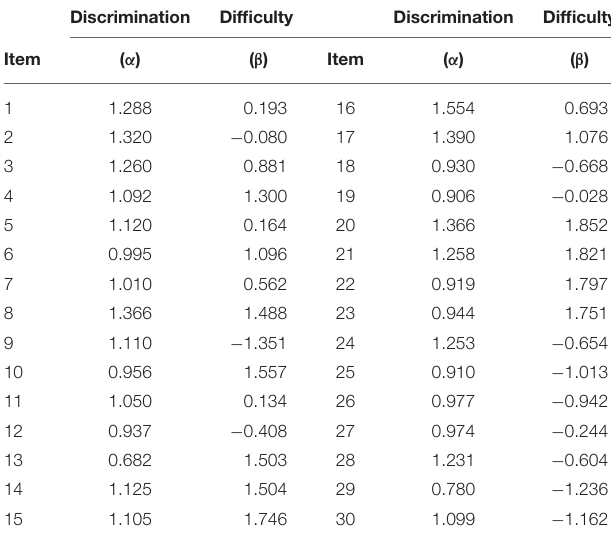
TABLE 2 | Item parameters used in the simulation study (First 30